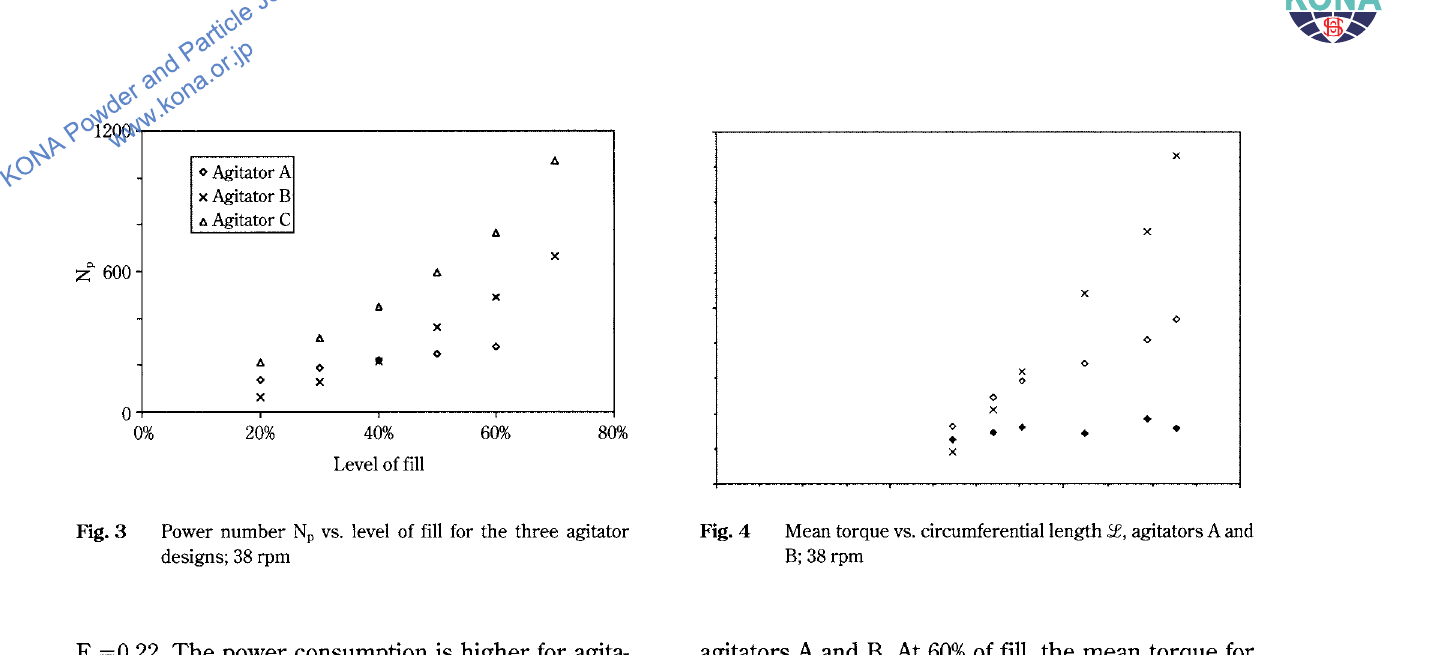
Fig. 3 Power number NP vs. level of fill for the three agitator designs; 38 rpm